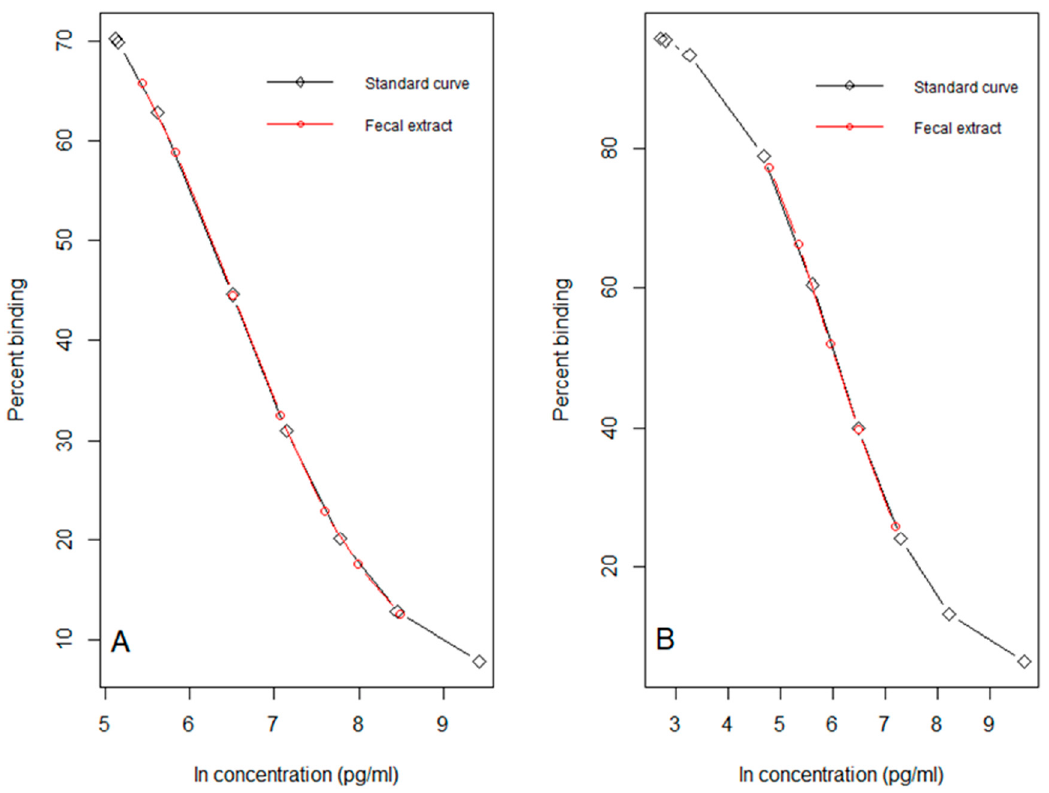
Figure 1. Parallelism curves for pooled fecal extract from deermice measured with ( A ) corticosterone enzyme immunoassay (EIA) and ( B ) group-specific EIA. Standard curves for each EIA are shown in black with each concentration as an open diamond. Parallelism is shown in red with serial dilutions of pooled fecal extract as open red circles.